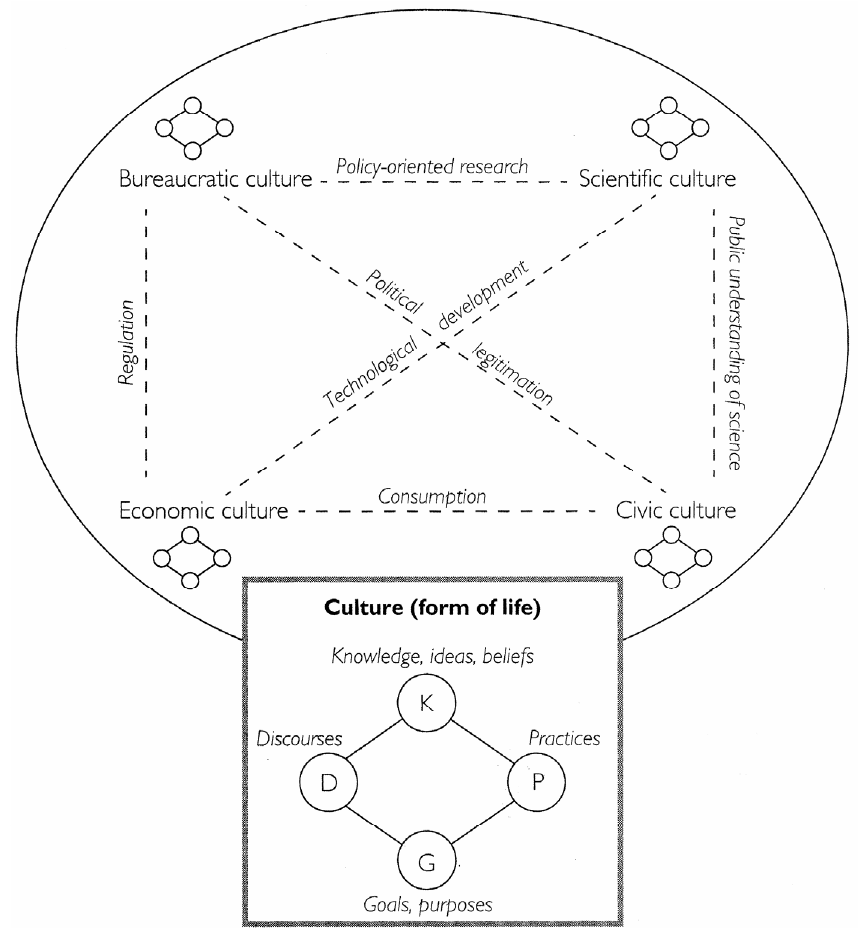
Figure 1. Illustration of the model of co-production of knowledge and society. Derived from Jasanoff and Wynne 1998 (Battelle Press: Columbus, OH, USA)